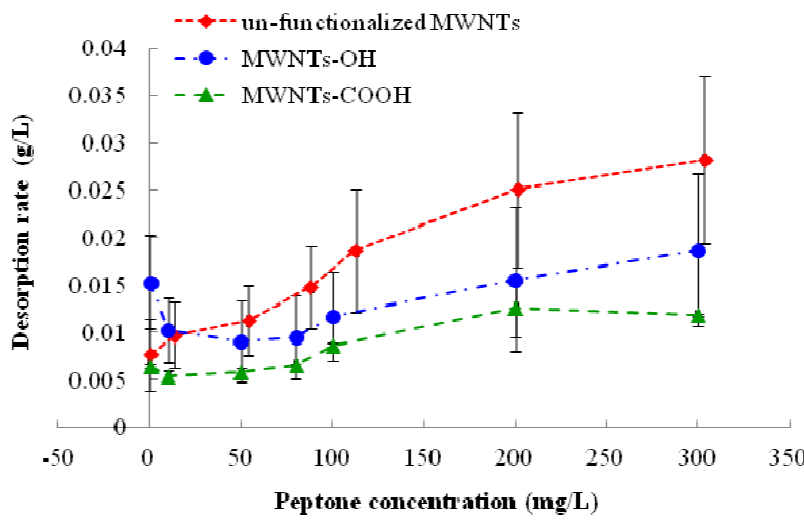
Figure 3. Change of the desorption rate of pre-loaded 1,3,5-TCB from MWNTs with concentrations of peptone in solution. The reported values are the average of three or four replicates. Error bars stand for standard